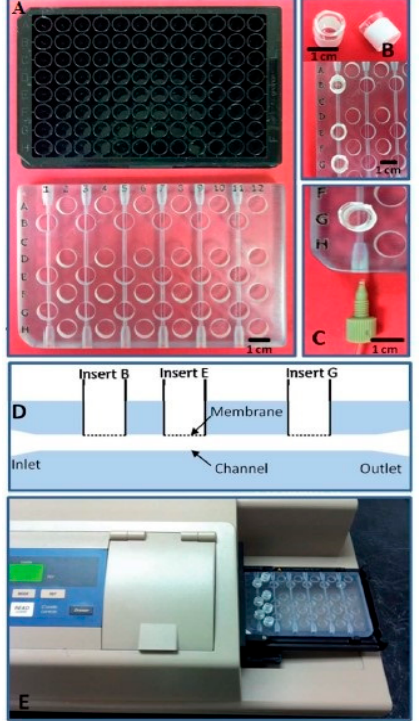
Figure 4. ( A ) The 3-D printed device has been modelled after the dimensions of a 96-well plate. ( B ) The inserting of the membrane is done into wells via a semi-permeable polyester membrane. ( C ) The channels are connected through threads, located at two ends of the channel. ( D ) A schematic cross-sectional view of the insertion of the channel and the membrane. ( E ) The locking of the device into the sample holder. Reproduced from Chen et al. [119] .